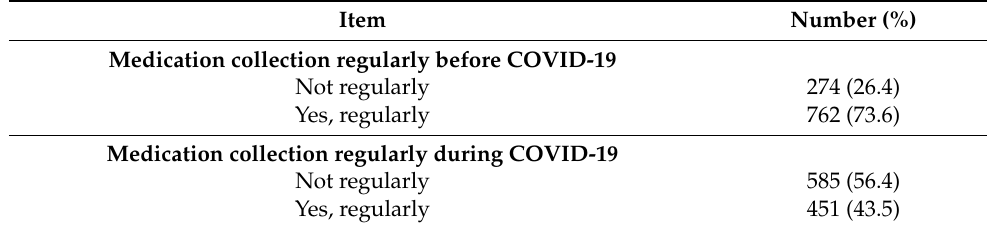
Table 3. Patients’ follow-up patterns before and during the COVID-19